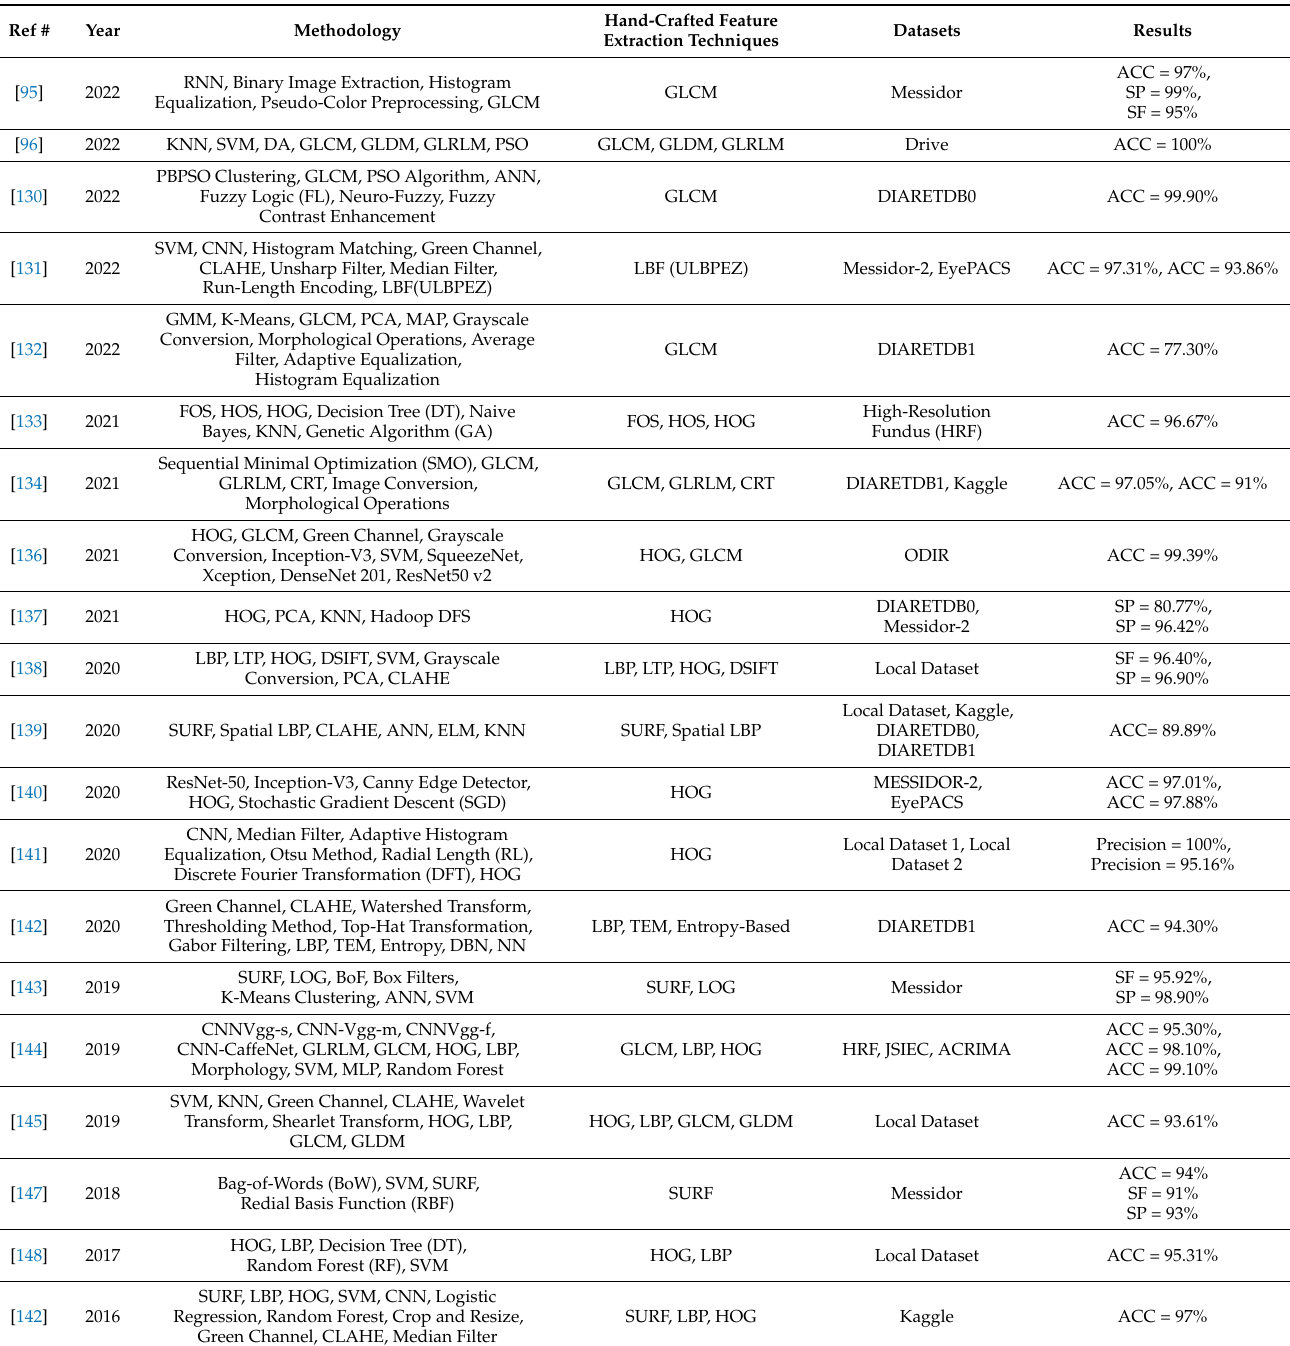
Table 5. Hand-crafted feature techniques used for DR